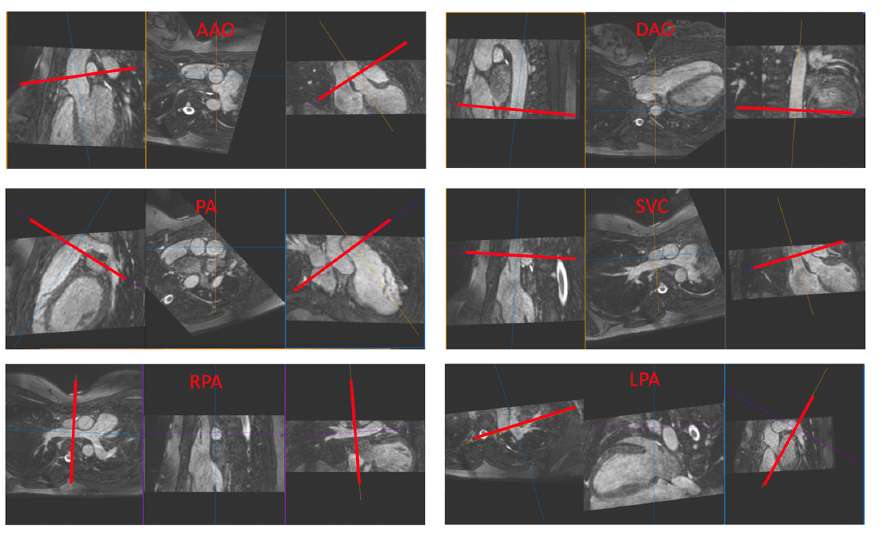
Table 1. Patient